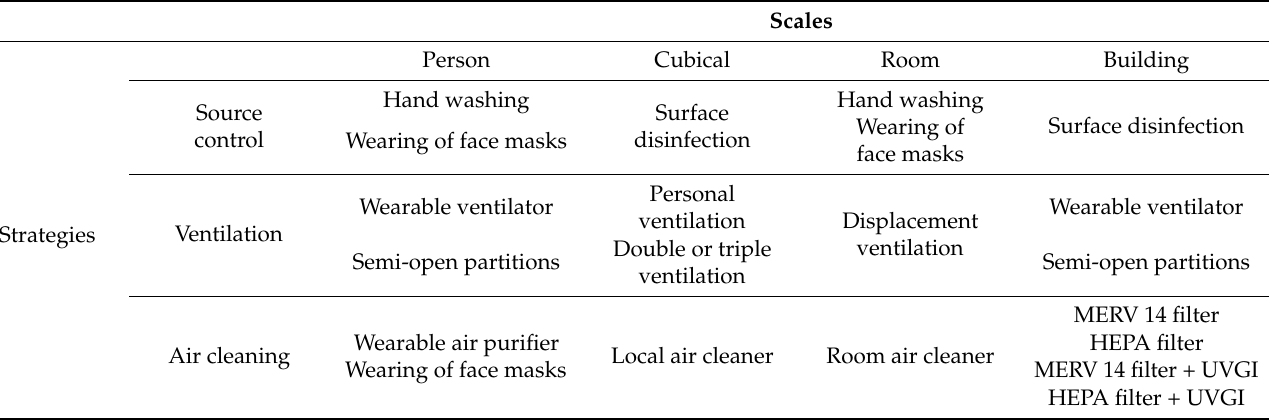
Table 1. Control strategies across different scales and estimated risk reduction factors.